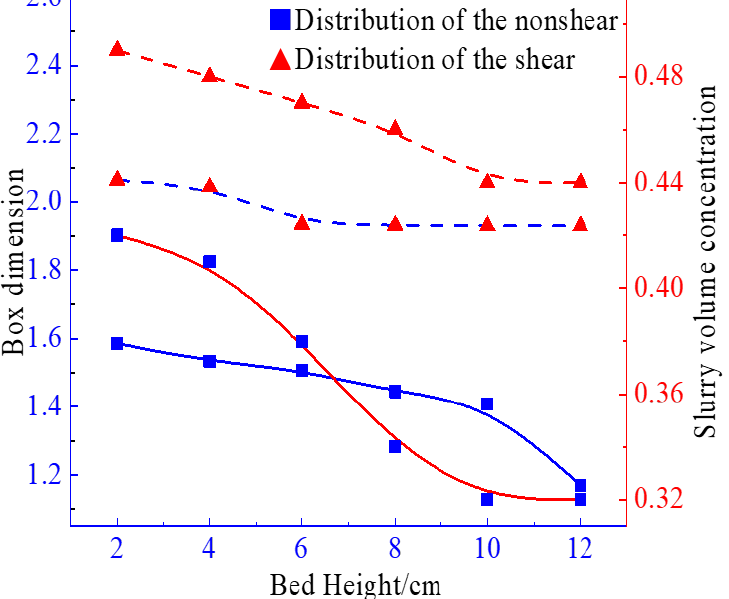
Figure 8. Binarization of the bed seepage channel distribution image under shear and box dimension calculation.